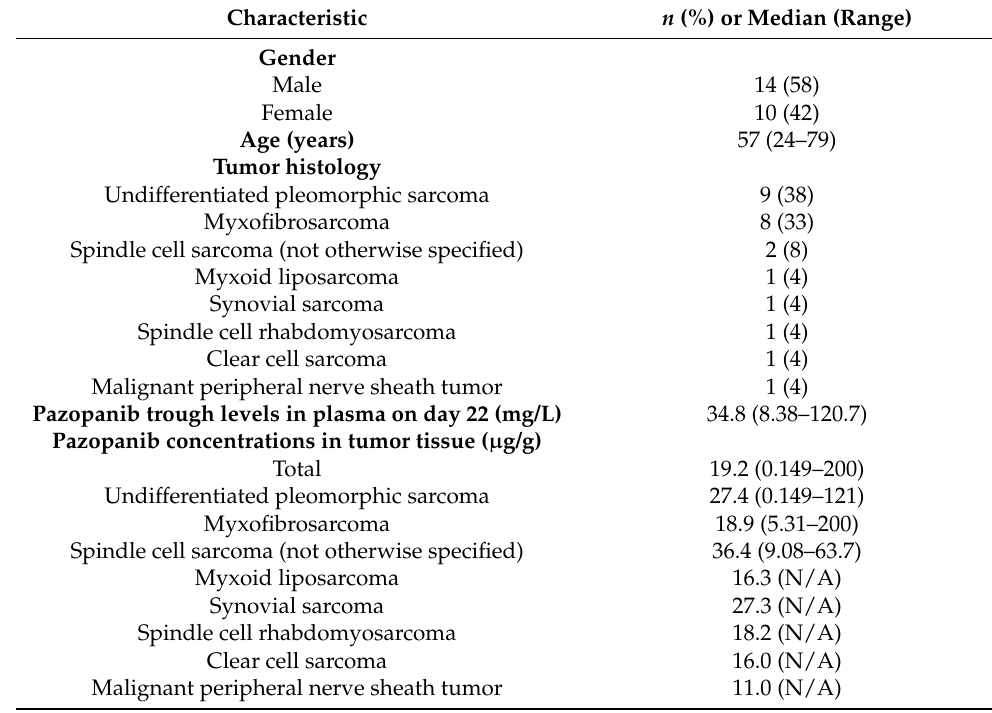
Table 1. Patient characteristics ( n =